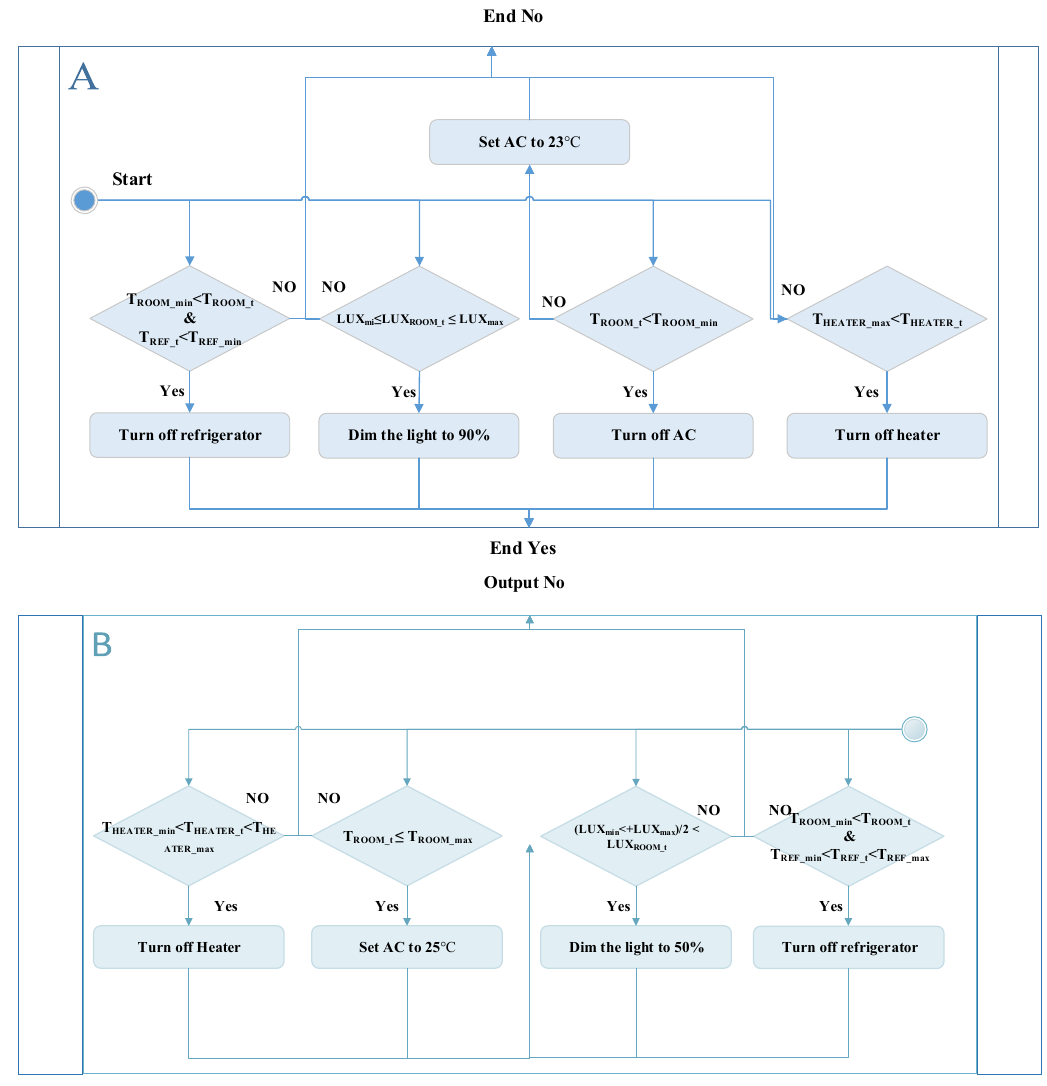
F igure 15. Complete flowchart of the energy management algorithm. Figure 15. Complete flowchart of the energy management